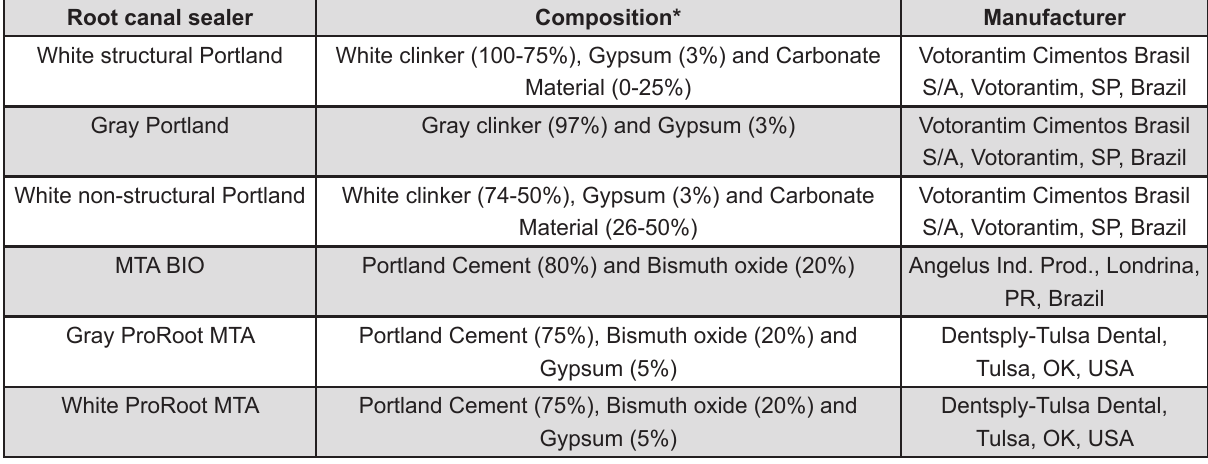
*information according to the Figure 1- Tested materials and compositions